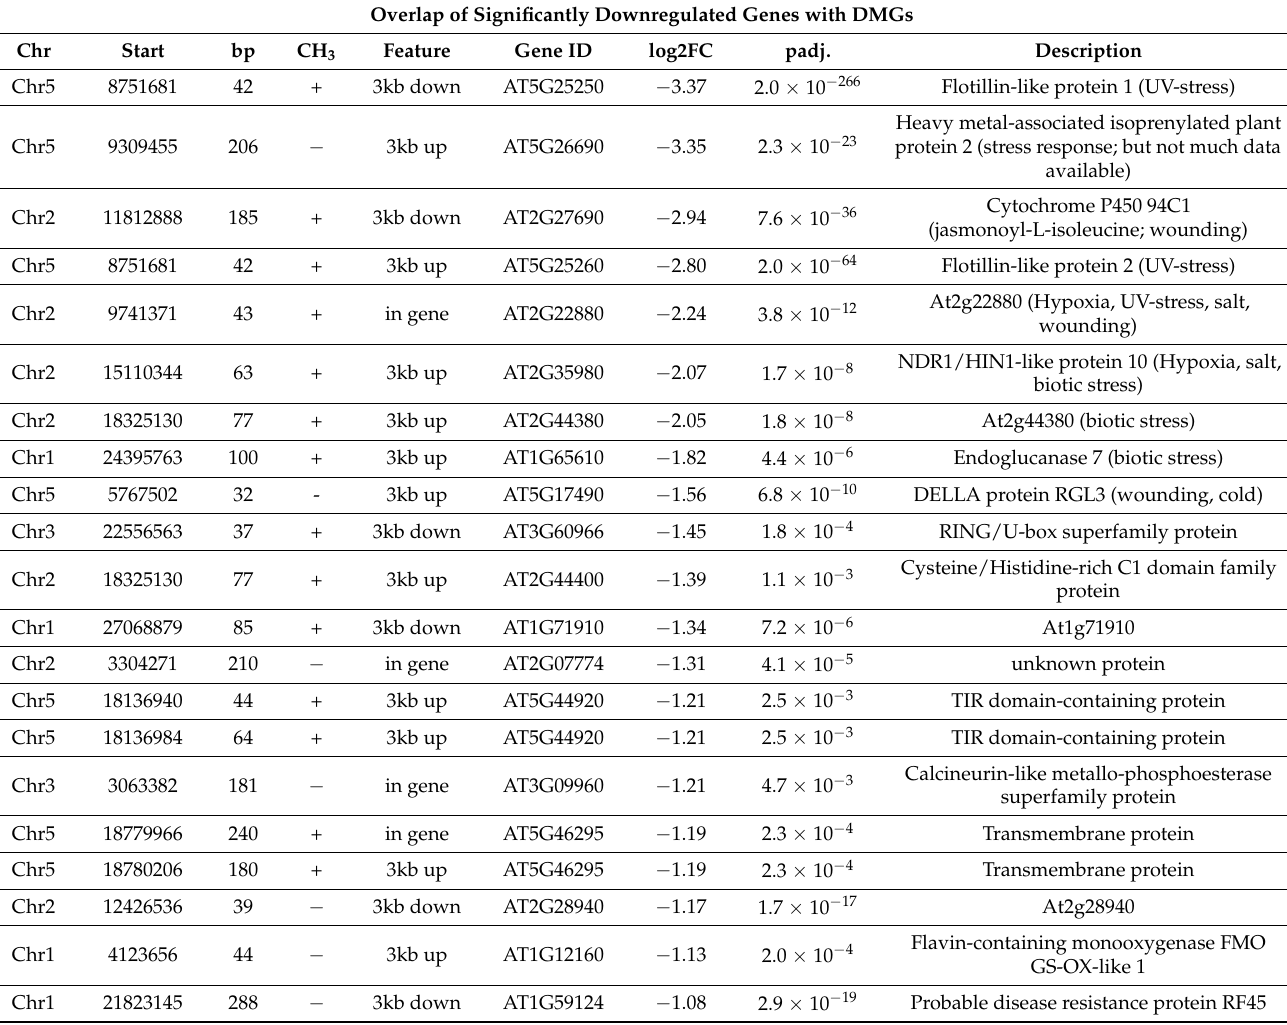
Table 3. Integrative analysis of DMGs and DEGs in gsnor1-3